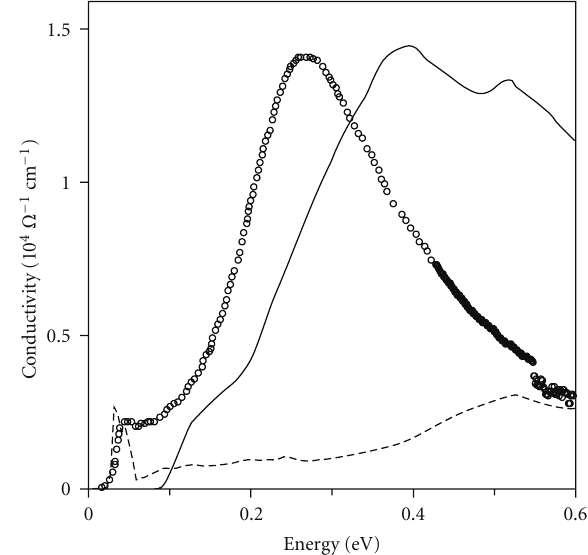
Figure 59: The experimental optical reflectivity spectrum R ( ω ) of YbB 12 (open circles) measured at 290 K [358] in comparison with theoretical calculations in the LSDA+ U approximation: dotted line for Yb 3+ , dashed line for Yb 2+ ions, and solid line for R = 0 . 2 ∗ R 2+ + 0 . 8 ∗ R 3+ [349].